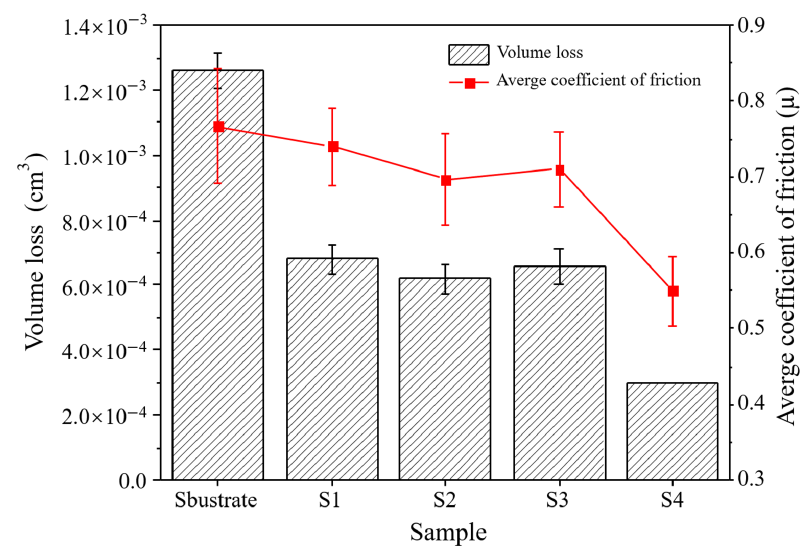
Figure 13. Wear volumes and average friction coefficients of the Stellite 6/WC composite coatings of different specimens.